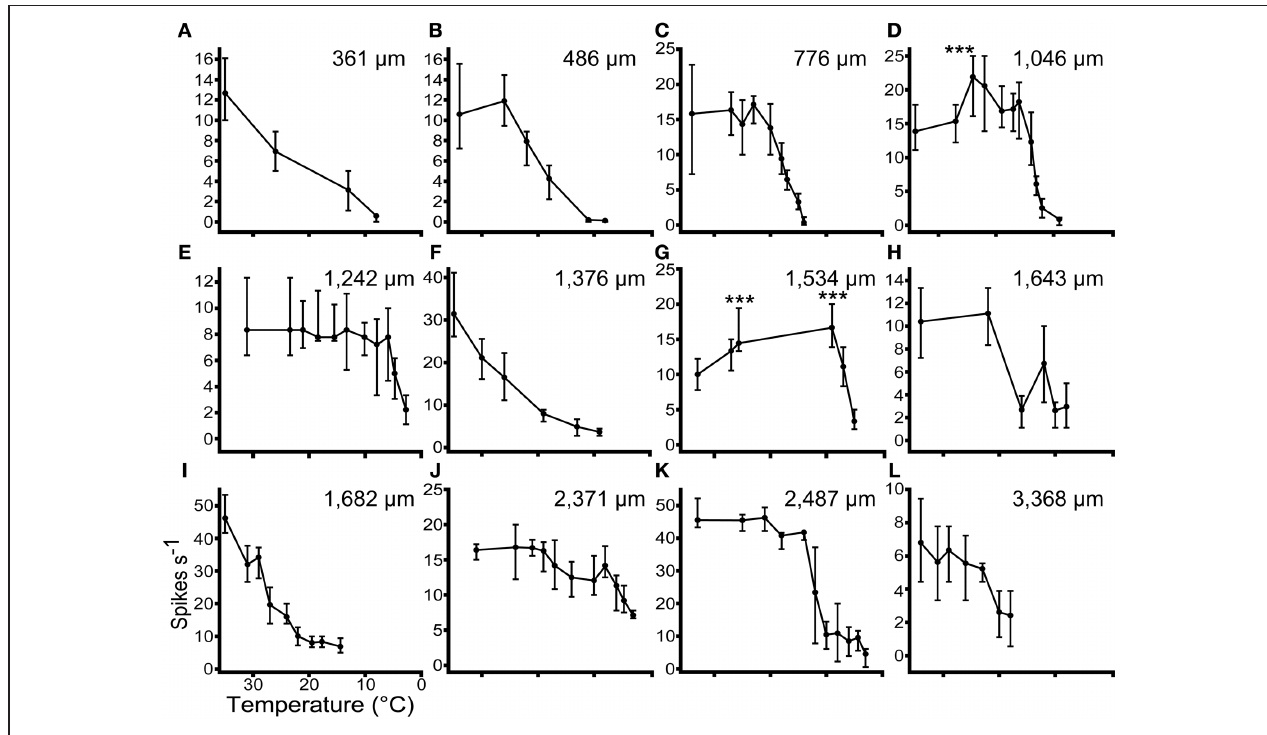
FIGURE 5 | The responses (Median ± IQR) of 12 single units to multiple presentations of a pure tone at CF, 20dB re threshold, during stepwise cooling of the IC. Units were recorded along the dorso-ventral axis of the IC from 361 μ m (A) to 3368 μ m (L) from